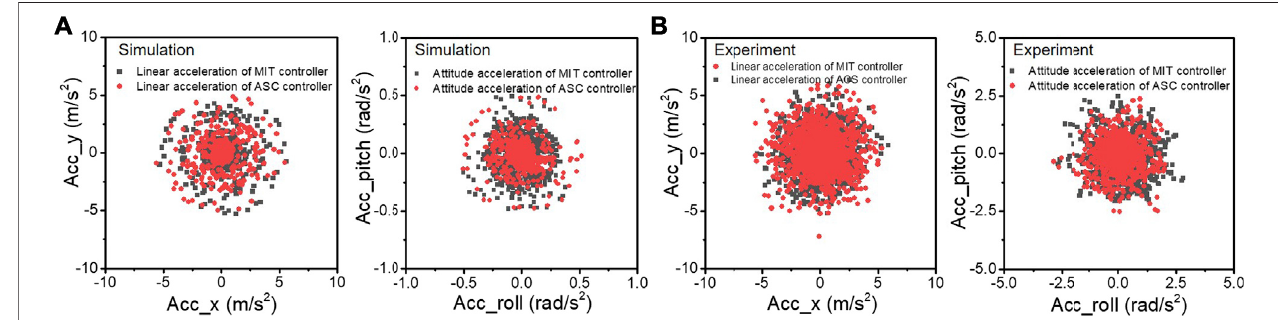
FIGURE 8 | The linear acceleration and angular acceleration of the robot during spinning experiments in simulation (A) and the quadruped platform (B) , respectively. The black and red lines represent the experimental results with MIT controller and our ASC controller, respectively.